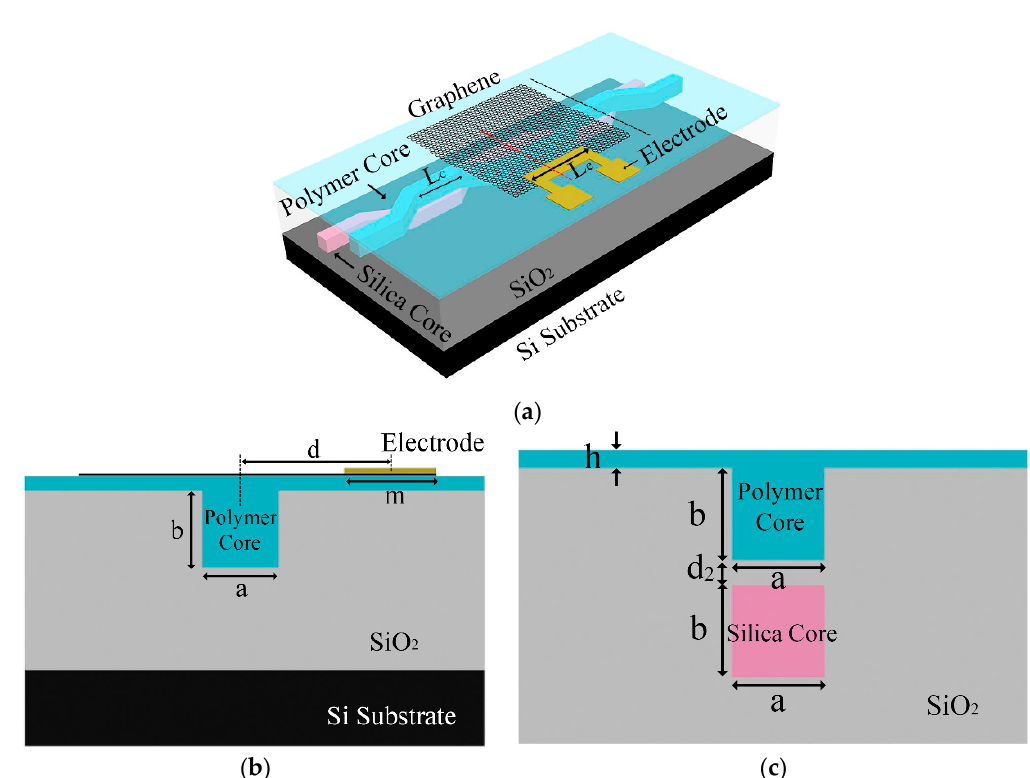
Figure 1. ( a ) Three-dimensional structure; ( b ) two-dimensional cross-sectional structure in the heating region (the position of the red dotted line in Figure 1a); and ( c ) two-dimensional cross-sectional structure in the 3-dB coupling regions (the position of the black dotted line in Figure 1a) of the inverted ridge 3D hybrid thermal optical (TO) switch with graphene film and side electrode structure. The dimensions of the core layers are a = b = 3 μ m. The parameters of m = 6 μ m, L e = 1 cm, and d 2